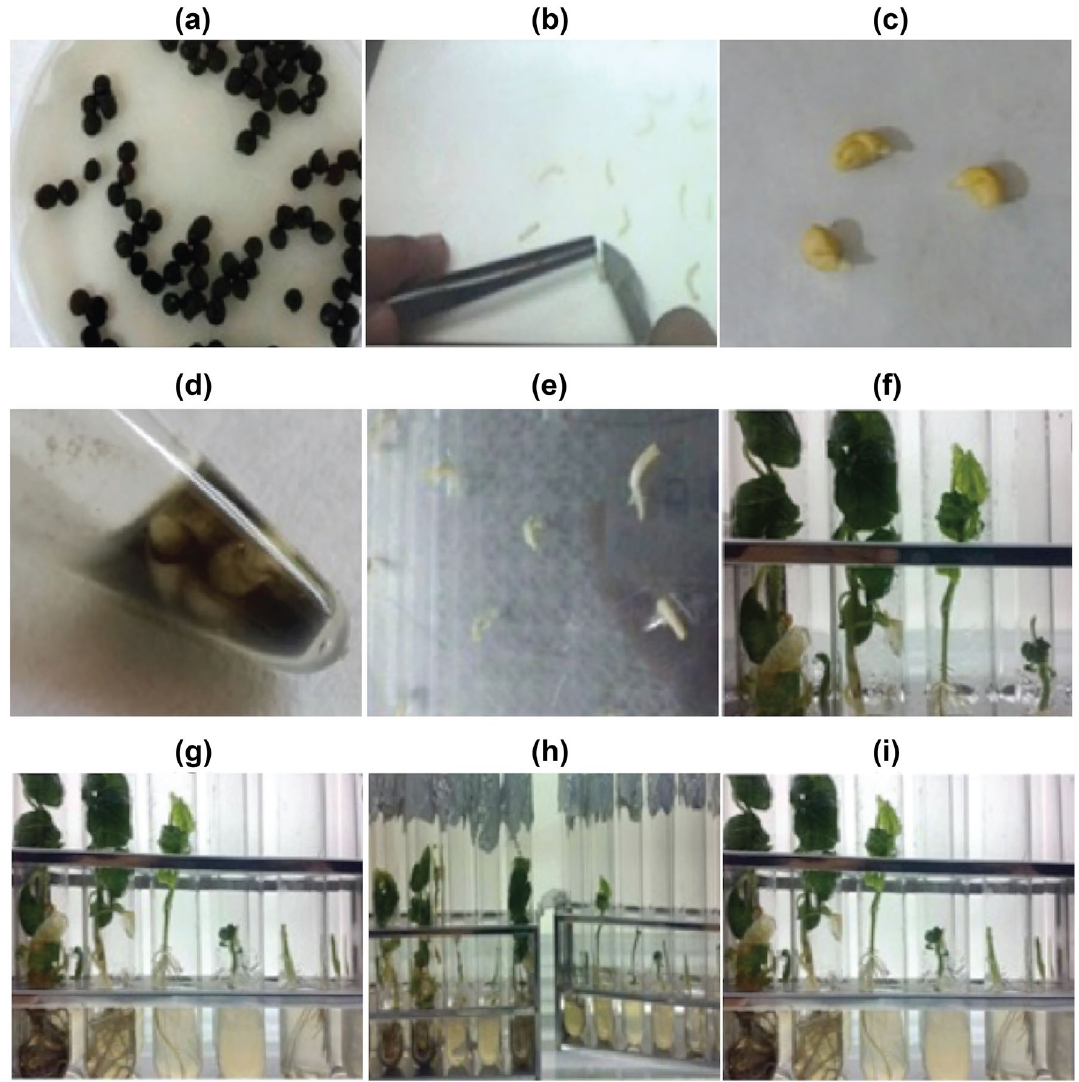
Figure 2. Schematic view of transformation steps. ( a ) Okra seed germination; ( b ) Isolation of Embryo; ( c ) Isolated embryo; ( d ) Plasmid-Iron Nanoparticle Complex formation; ( e ) Incubation of embryos in MS medium; ( f ) Embryo in shooting media; ( g ) plants in rooting media; ( h ) plants After 15 days; ( i ) and Different stages of